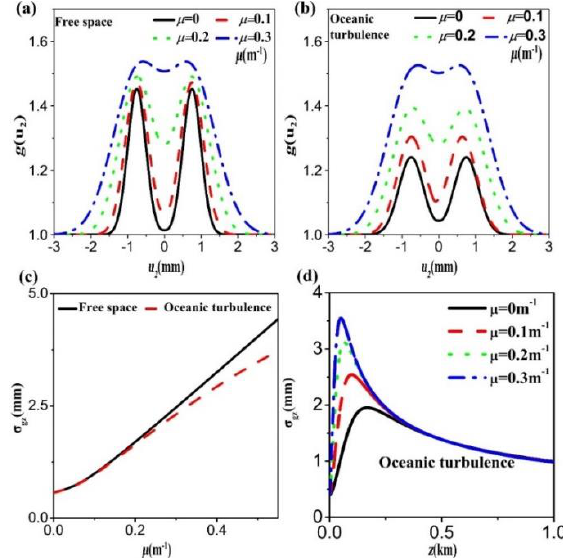
Figure 2. Image of the double slits ( a ) in free space and ( b ) in oceanic turbulence; ( c ) the variation of the coherence width with the twist factor both with and without turbulence. ( d ) Evolution of the coherence width with the propagation distance in turbulence at several values of twist factors.